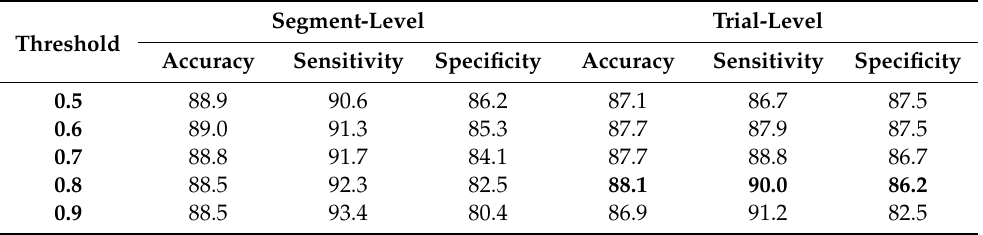
Table 5. Average testing accuracy, sensitivity, and specificity for di ff erent values of the probability threshold on segment-level and trial-level. LOSO evaluation